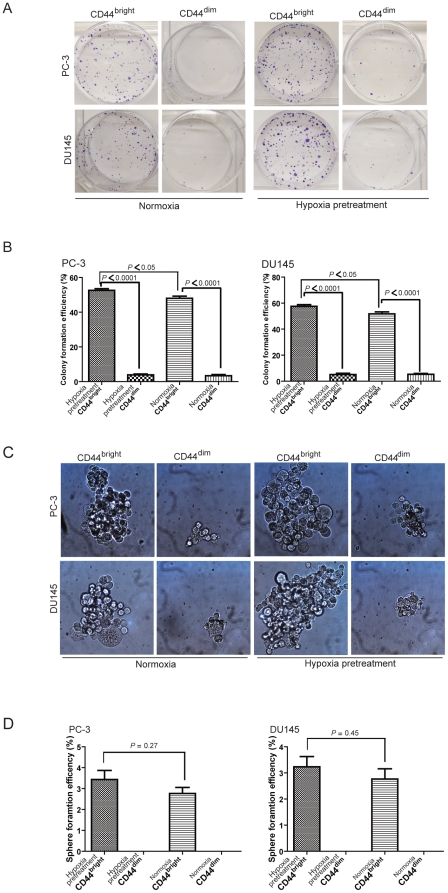
CD44bright cells show stem-like properties.(A) For both PC-3 and DU145 cell lines, more colonies are shown in the CD44bright cells than the CD44dim cells under nomoxia condition, while even more colonies can be seen in the CD44bright cells pretreated under 1% O2 for 48 hours. (B) Histograms for the colony formation efficiency show statistically significantly higher efficiency in the CD44bright cells than the corresponding CD44dim cells (P<0.0001 for both cell lines), and even higher level efficiency in the hypoxia- pretreated CD44bright cells in comparisons with the CD44bright cells without hypoxic pretreatment (P<0.05 for both cell lines). (C) Sphere formation assay shows spheres in the CD44bright cells in both normoxia and hypoxic pretreated cells while there is no qualified sphere in the corresponding CD44dim cells for both cell lines. (D) Histograms show sphere formation efficiency in the CD44bright and CD44dim cells with and without hypoxia pretreatment.